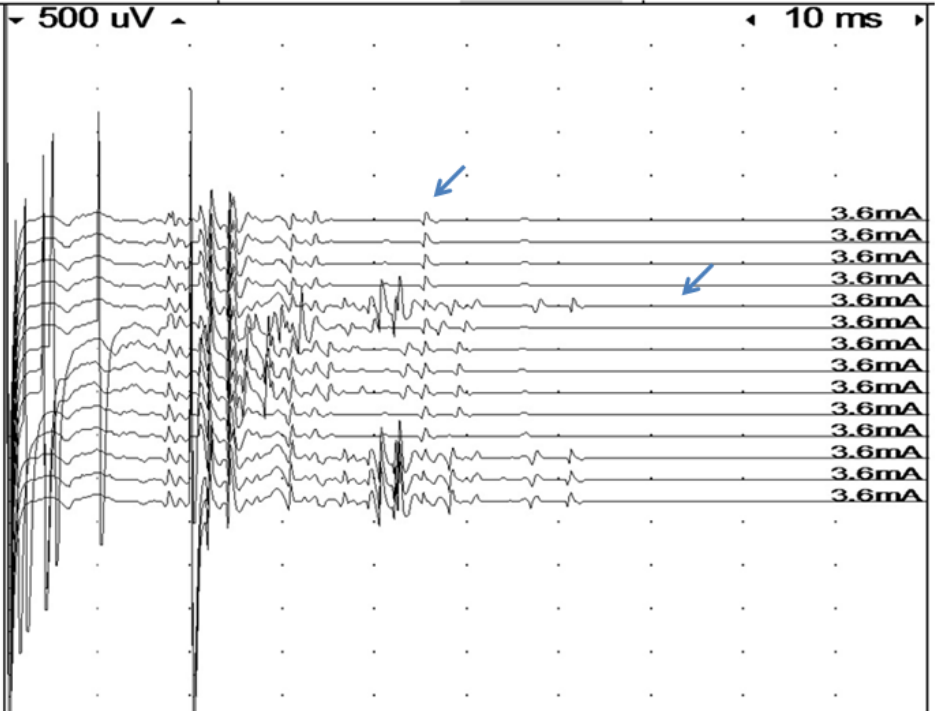
Figure 2. Assessment of refractory period in a very complex signal by double muscle stimulation (high stimulus artifacts indicate time of first stimulation at the beginning of the sweep, and of the second stimulation). The first four traces show single stimulation with a very time-dispersed response and late components. As soon as an extra stimulus is delivered, at an interval of 20 msec, the last component arrows (probably a single fiber action potential), disappear, indicating a very long refractory period in this